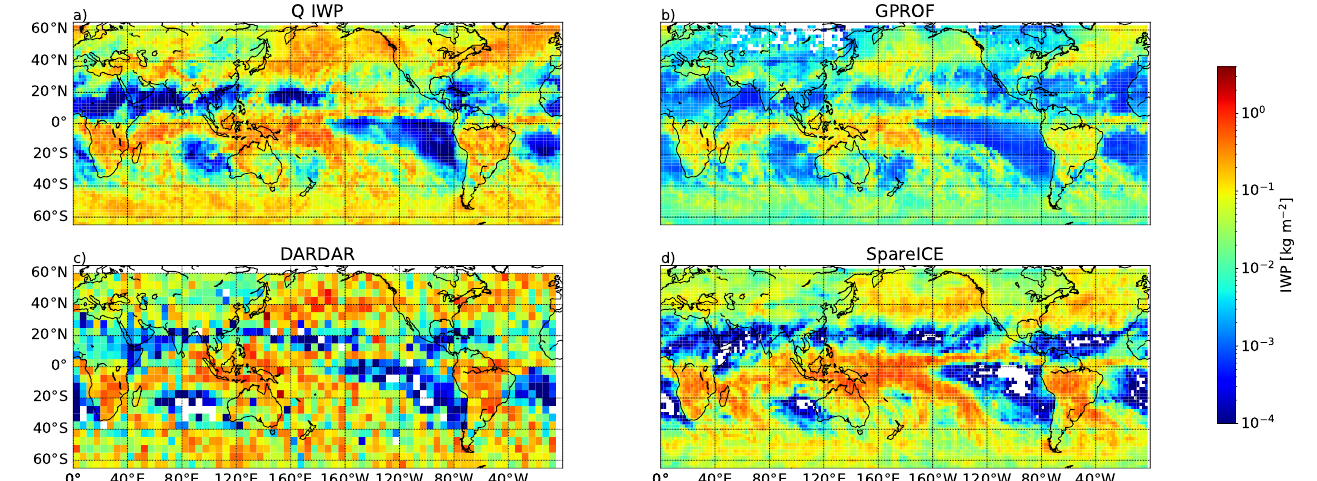
Figure 16. ( a – d ) The gridded mean of the IWP observations for Q-IWP, GPROF, DARDAR and SPARE-ICE. Q-IWP, GPROF and DARDAR data were from January 2017, while SPARE-ICE data were from January 2013. DARDAR is gridded at 5 ◦ grid, while the other three datasets are gridded at 2 ◦